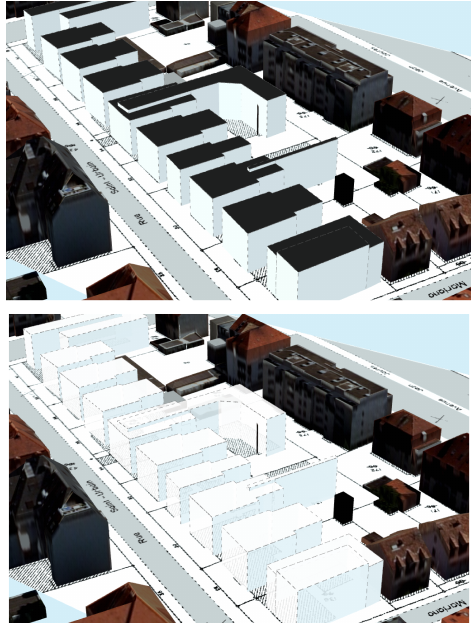
Figure 8. Visual effect of the differentiation of walls and roofs discreet style in a photo-realist context: upper image: differenti- ation between walls and roofs; lower image no differentiation.